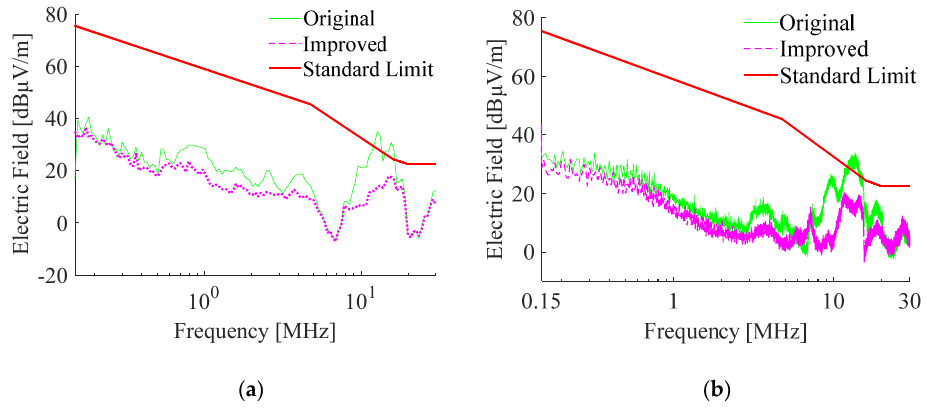
Figure 12. Problem analysis results: ( a ) Importance analysis results; ( b ) Hierarchical analysis for final solution.